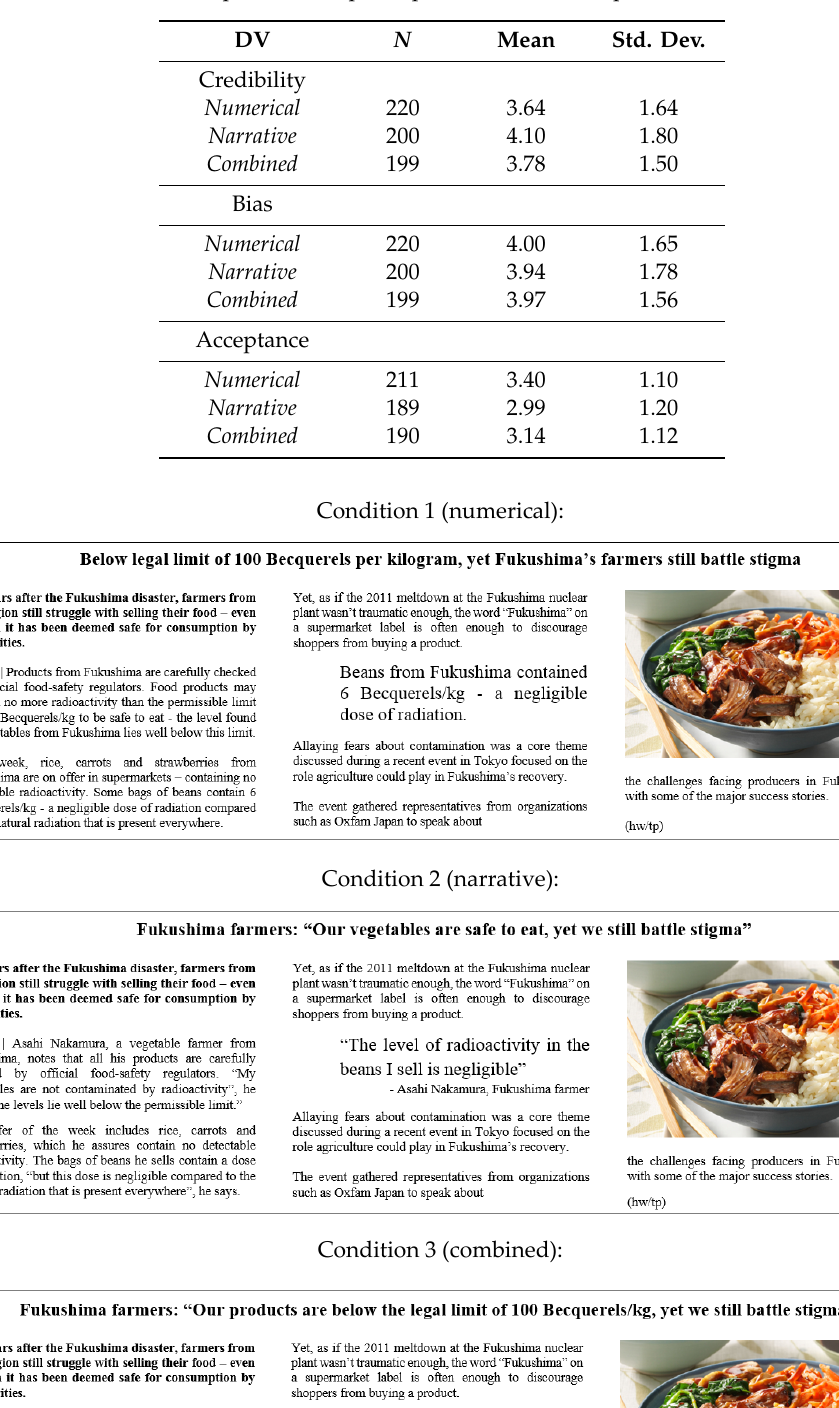
Table A2. Descriptive values per dependent variable, experimental condition.